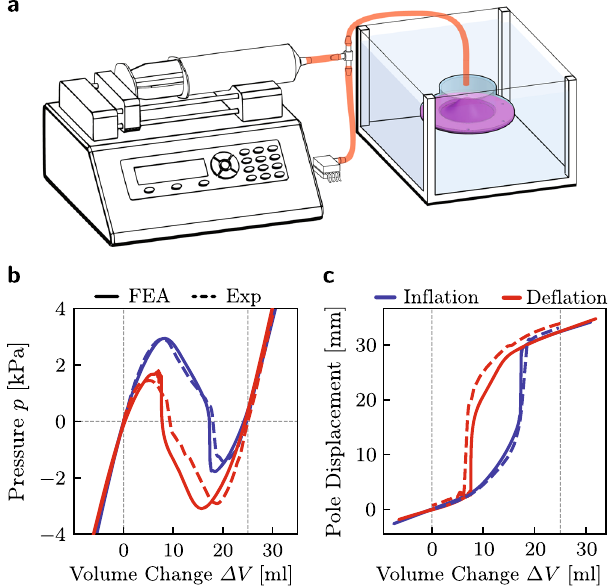
Fig. 2 Experimental characterization of our universally bistable thick shells. a Schematic of the experimental setup used to quasi-statically in fl ate and de fl ate the universally bistable shells using water, while being submerged in a water tank. b , with c Quasi-static pressure-volume and pole displacement-volume relationships obtained upon in fl ation (blue lines) and de fl ation (red lines) of a double shell with H / R = 0.59 and T total / R = 0.158 (with R = 25.4 mm) in experiments (dashed lines) and FE simulations (solid lines). Vertical black lines indicate the location of the two stable states for the